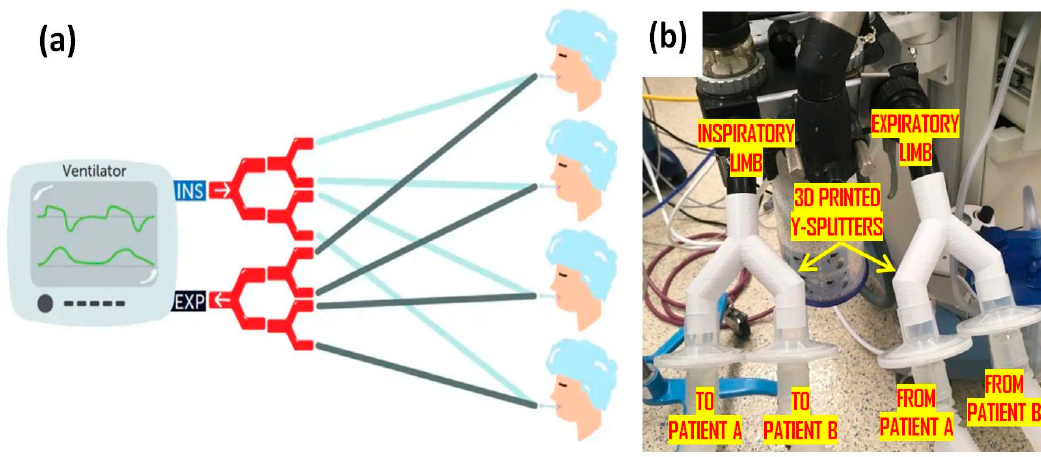
Figure 9. Ventilator splitter: ( a ) schematic representation; ( b ) splitters connected to a shared venti- lator [69].